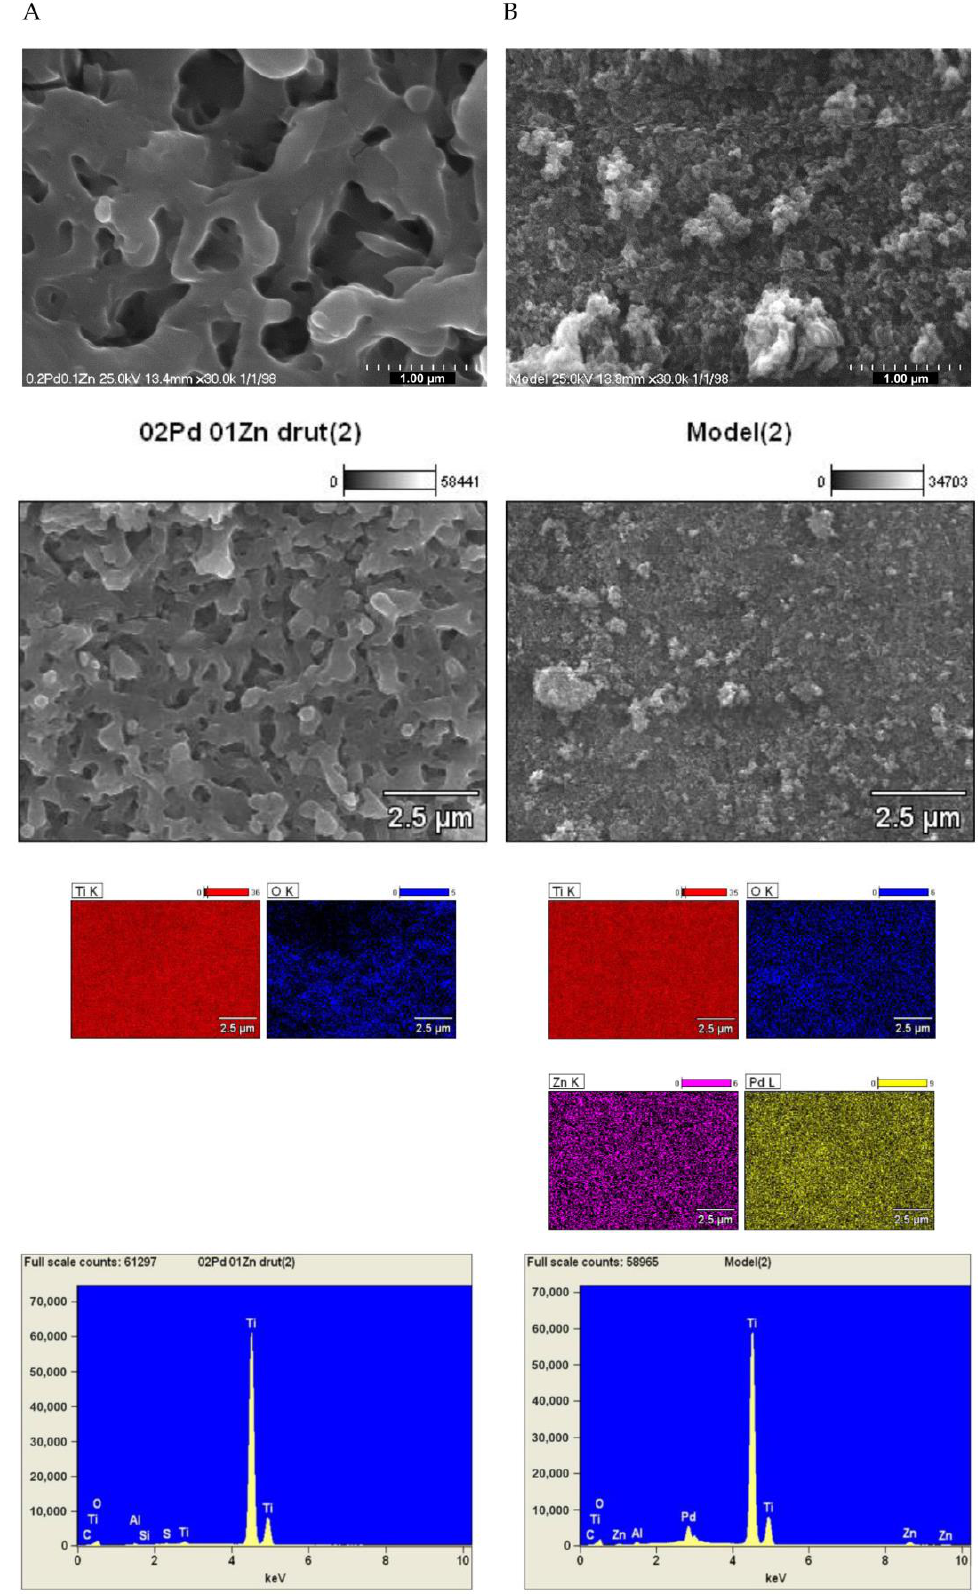
Figure 4. Pictures and analysis of elemental composition (maps) made using the SEM-EDS technique for ( A ) Pd-Zn/TiO 2 /Ti wire catalyst (Pd:Zn = 2:1) and ( B ) model Pd-Zn/TiO 2 catalyst (Pd:Zn = 2:1).